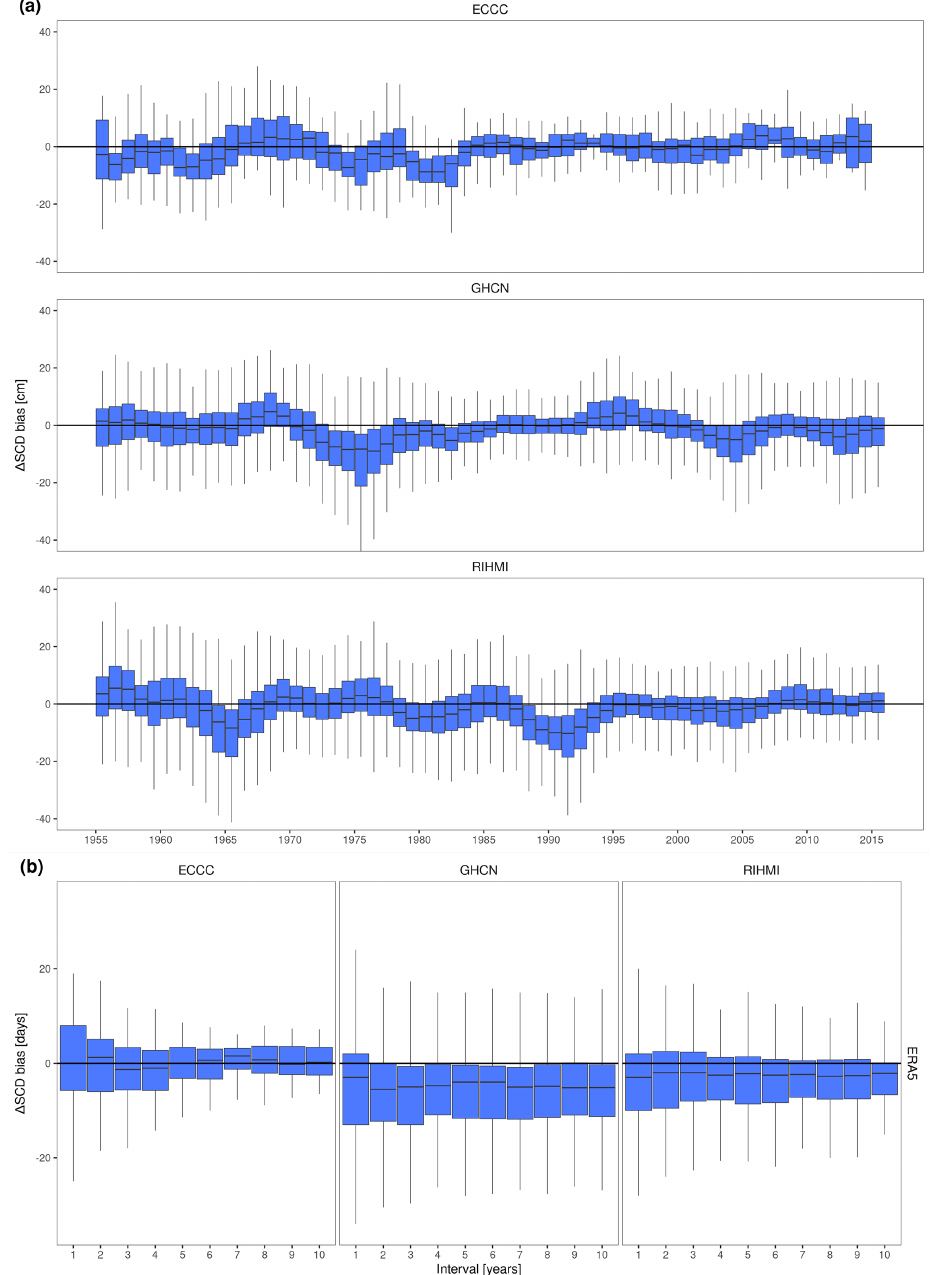
Figure A1. Sensitivity analysis to determine (a) the exact year of step discontinuities and (b) the interval used to estimate the magnitude of the discontinuity. (a) Change in ERA5 (cid:49) SCDbias (before – after) when the step year varies from 1955 to 2015. (b) Change in ERA5 (cid:49) SCDbias (before – after) during the 2004 discontinuity when the number of years used for its calculation (interval) is varied from 1 to 10.